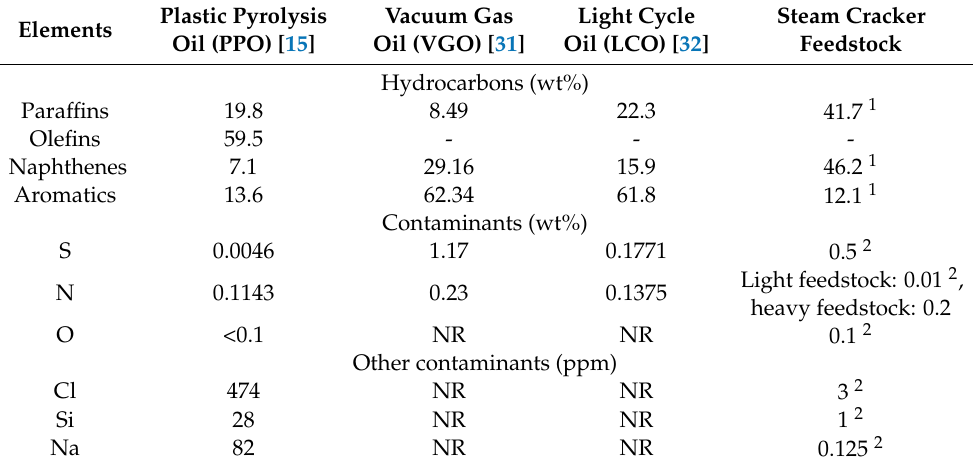
Table 3. Composition and contaminants present in pyrolytic oil, VGO, LCO and stream cracker